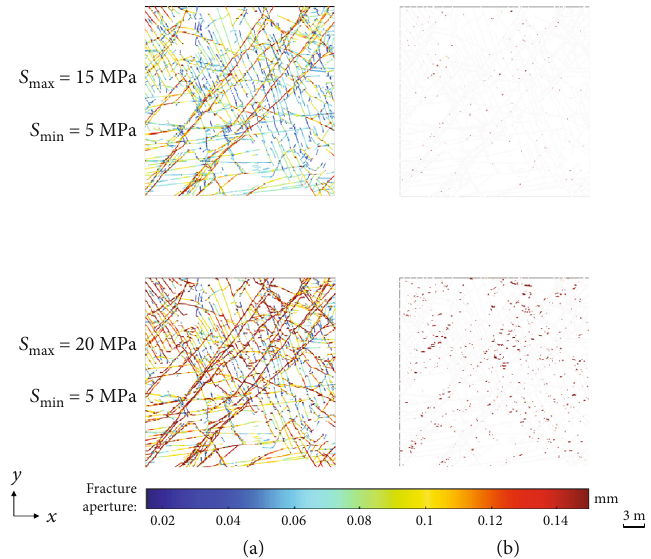
Figure 7: Formation of new cracks under high di ff erential stress conditions. (a) All fractures; (b) location and aperture of new cracks.